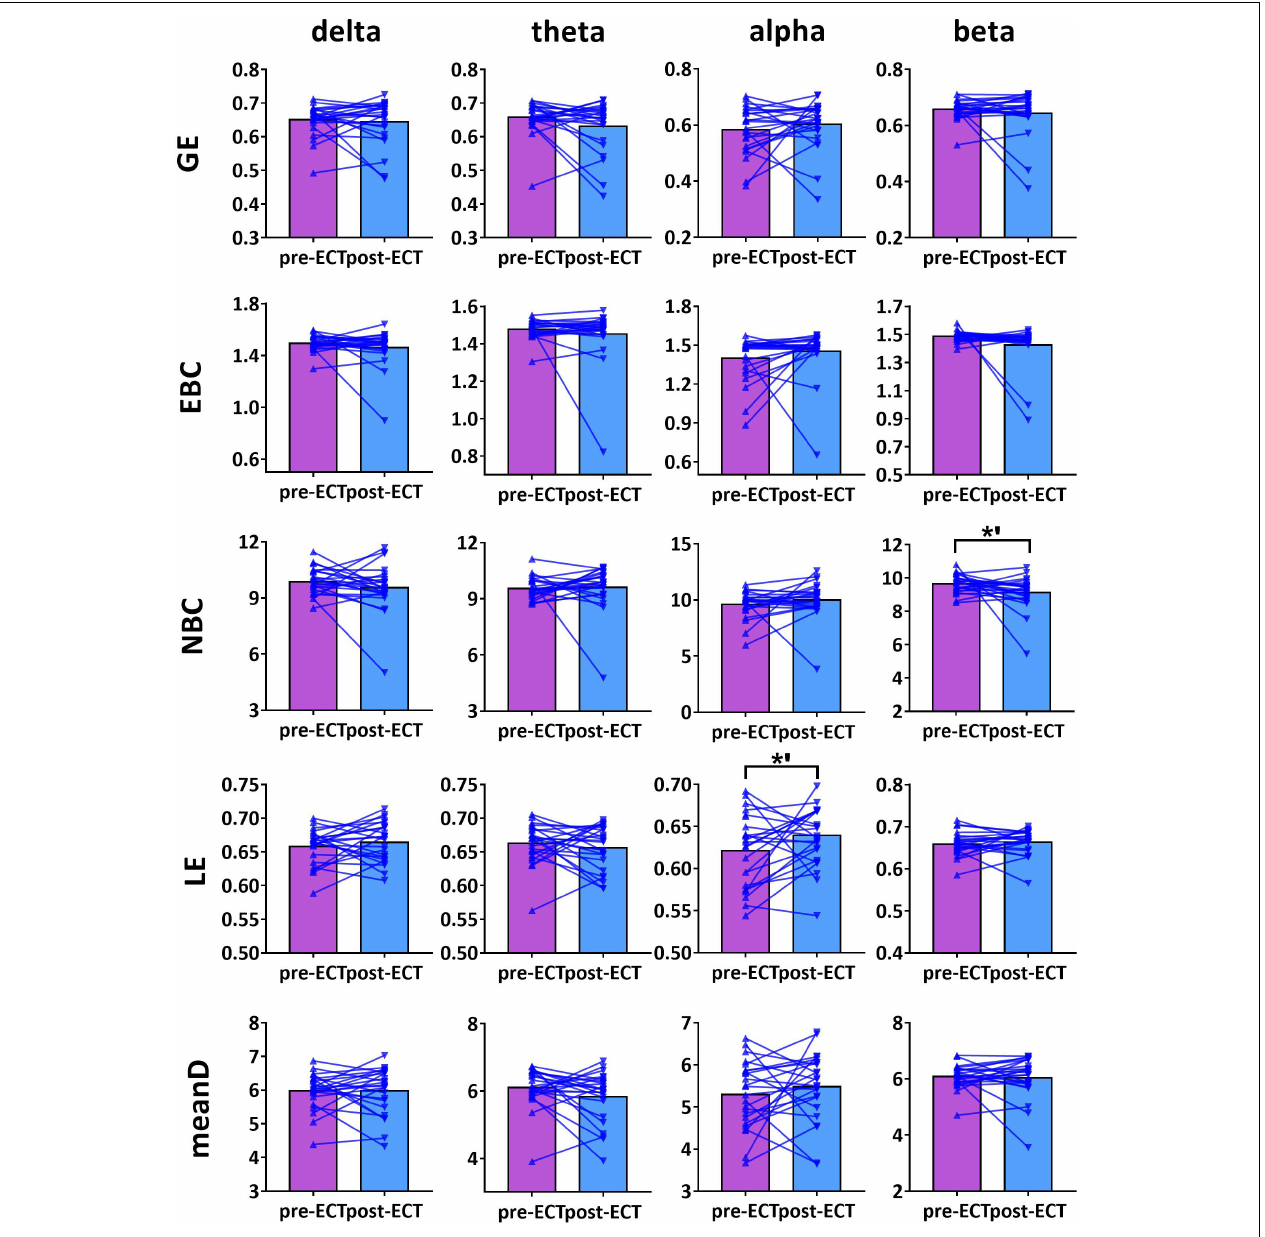
FIGURE 5 | Network metrics of pre- and post-ECT patients with MDD obtained by coupling method PLI and binarization approach CST in delta, theta, alpha, and beta frequency bands. Other descriptions are as in Figure 3